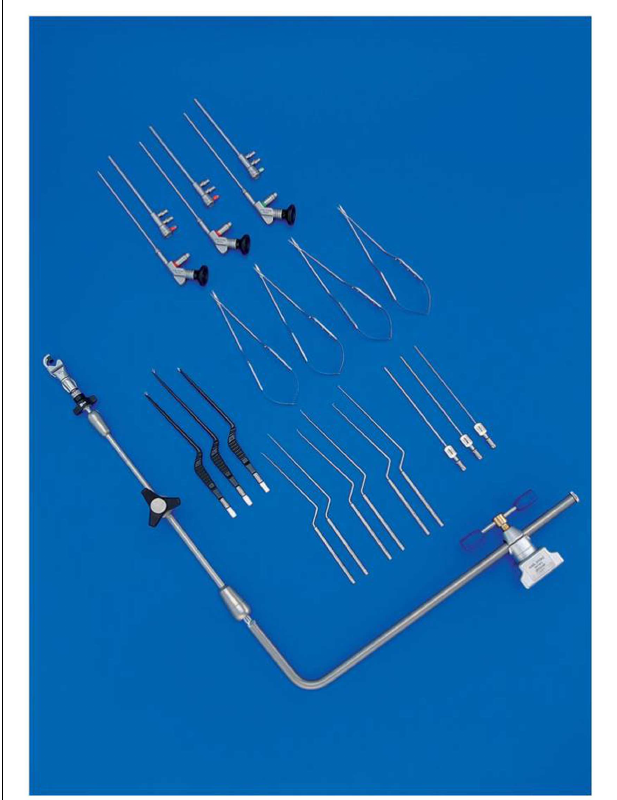
FIGURE 1 | Endoscopic instruments and mechanical holding system retractor arm used .